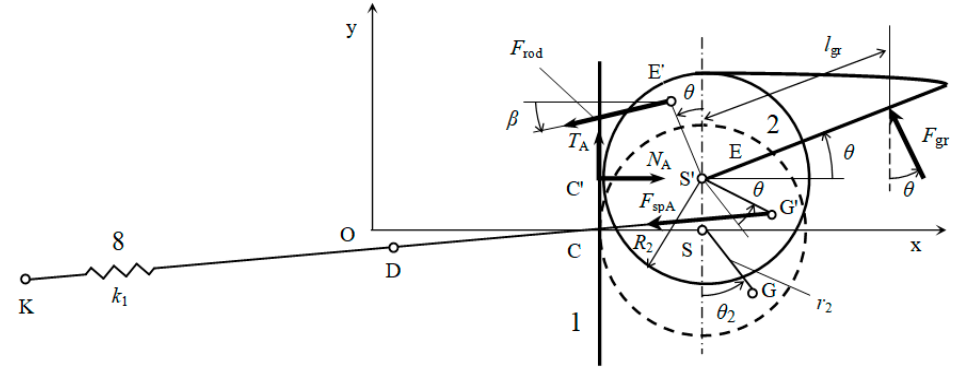
Figure 4. Freebody diagram—roller